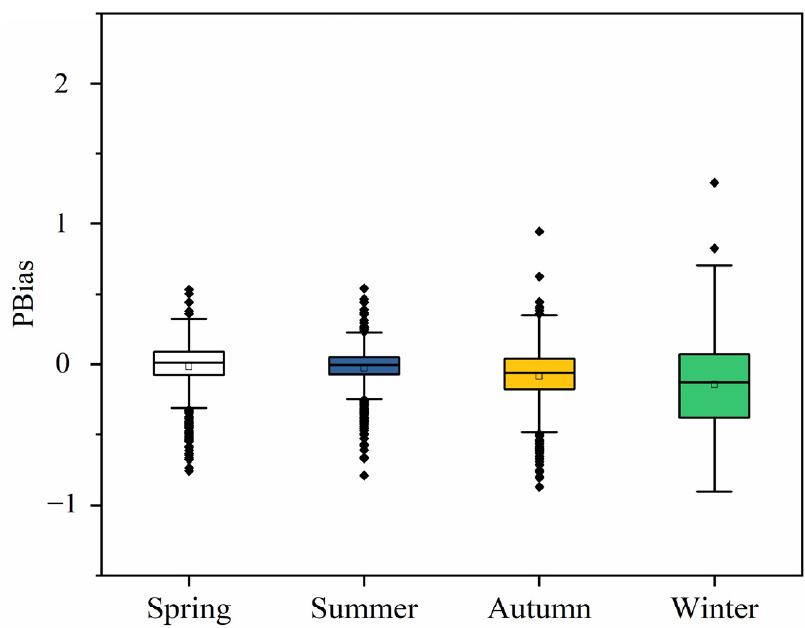
Figure 10. The box diagram of Seasonal PBias of ET 0 calculated from CLDAS dataset.